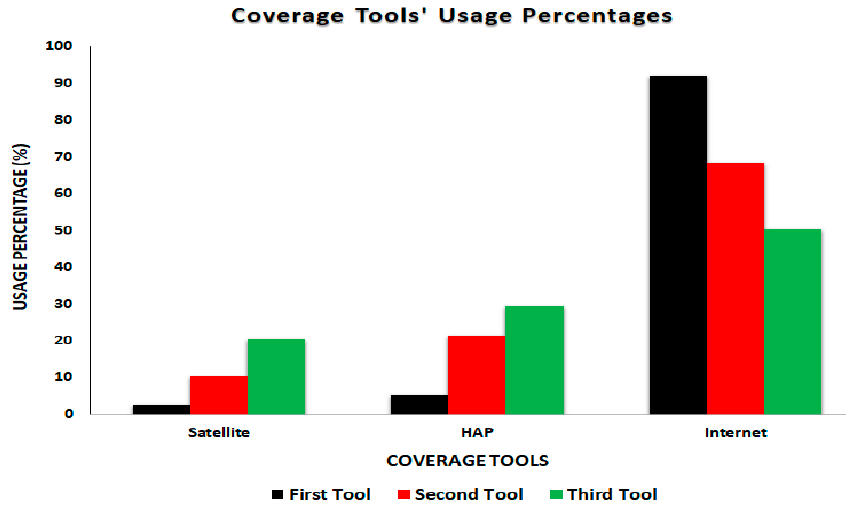
Figure 11. Usage of coverage tools.